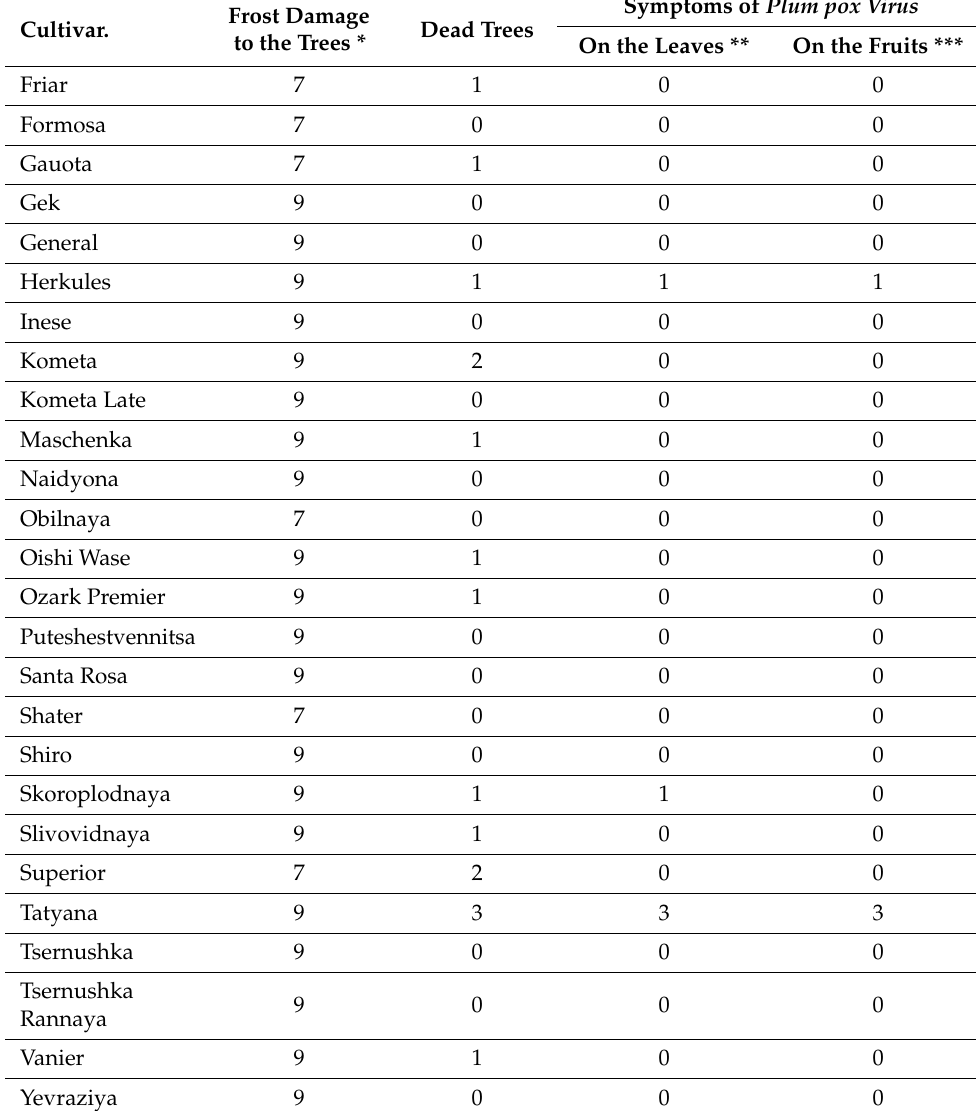
Table 1. Cont. Cultivar.